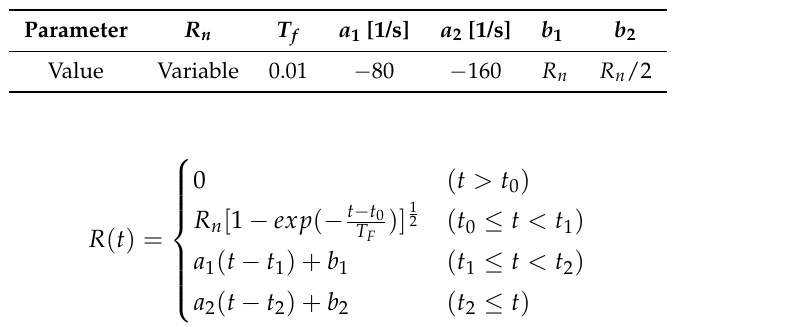
Table 3. Parameter of superconducting fault limiter